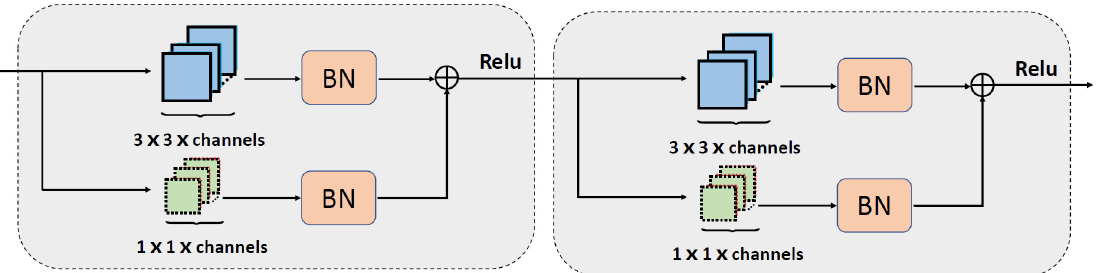
Figure 2. Network architecture of